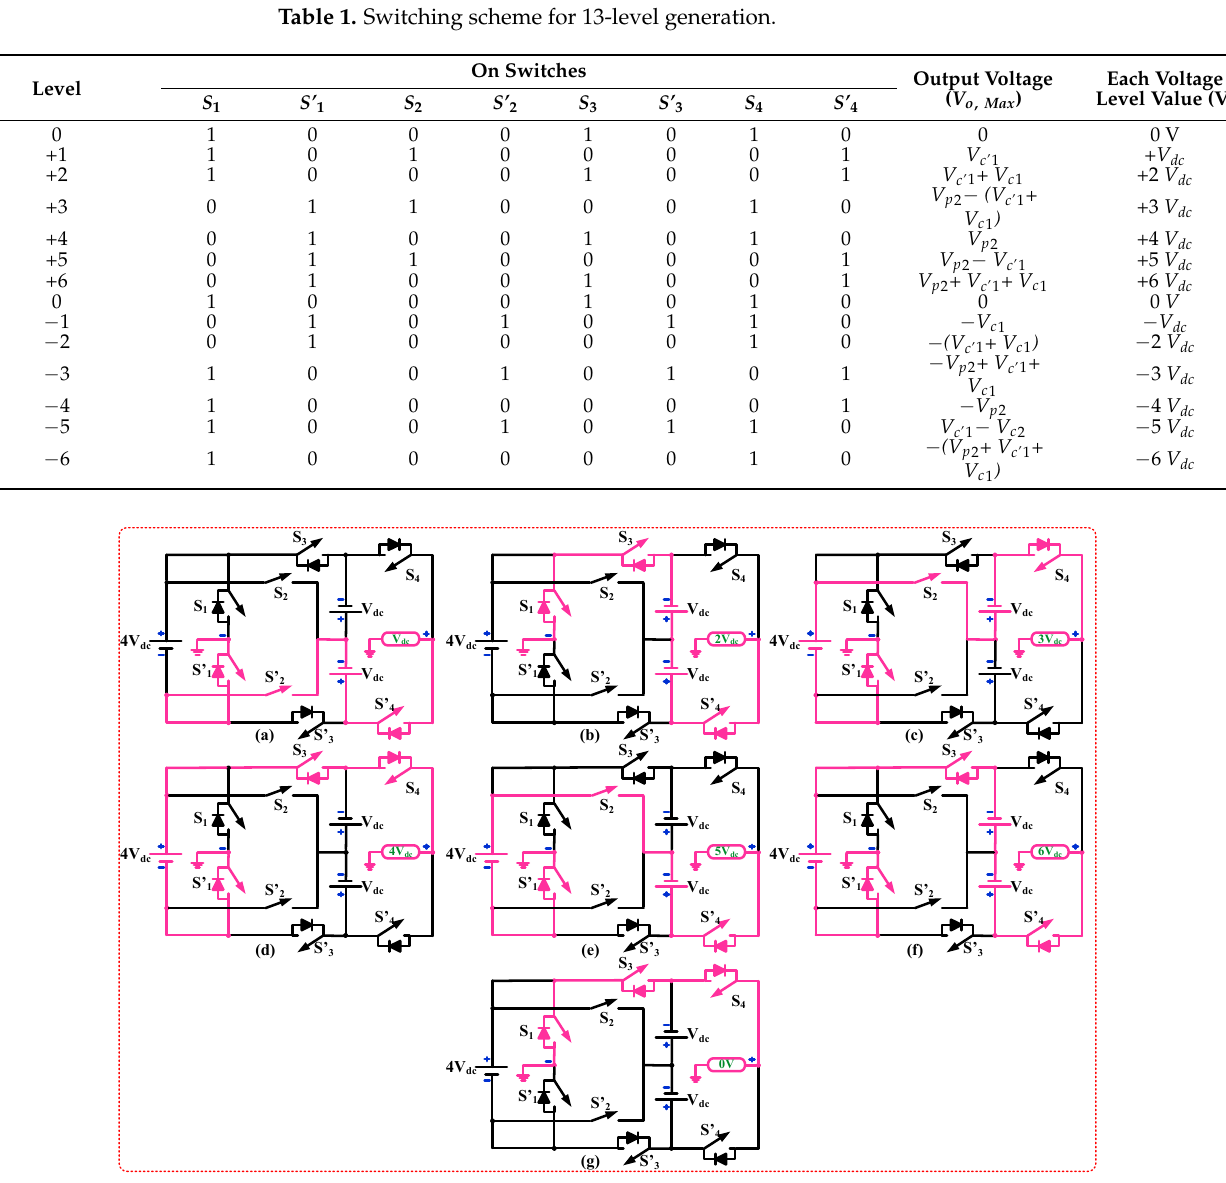
Figure 2. Various voltage-level generations of the proposed module. ( a ) V dc level ( b ) 2 V dc level ( c ) 3 V dc level ( d ) 4 V dc level ( e ) 5 V dc level ( f ) 6 V dc level ( g ) 0 level .